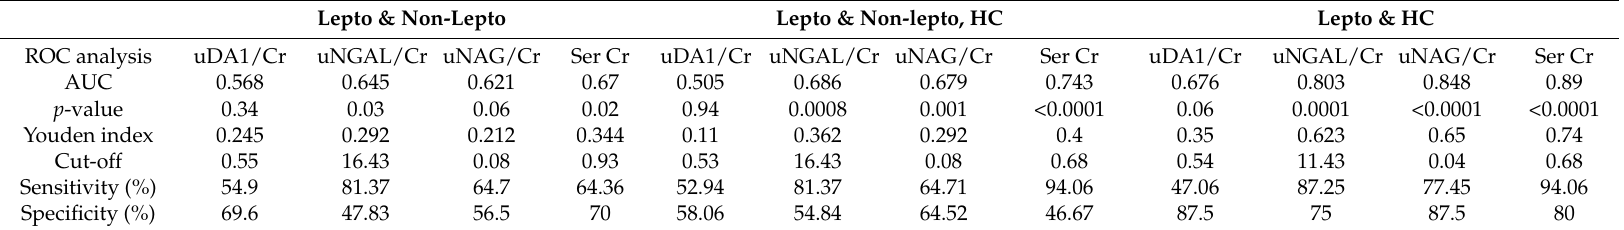
Table 3. Summary of ROC curve